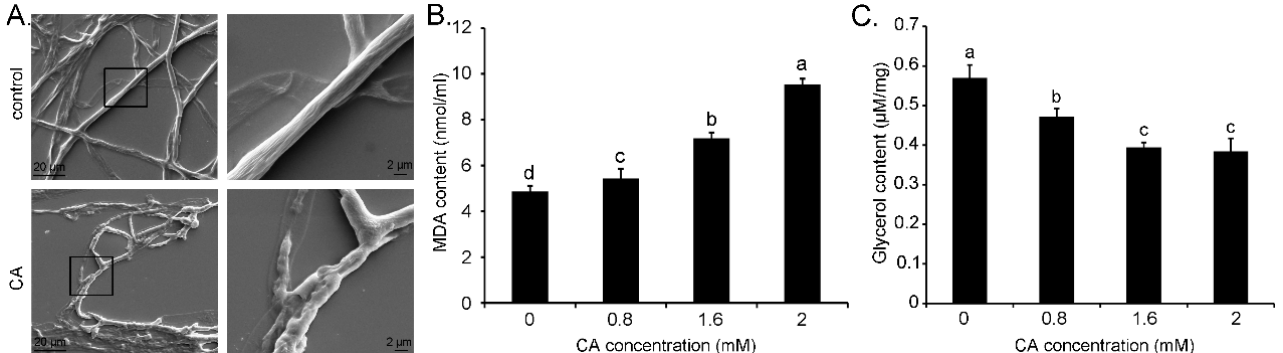
Figure 2. The defect in cell wall integrity of mycelia treated with CA/ ( A ) SEM observation of the hyphal morphology of P. capsici treated with 1 mM CA; ( B , C ) MDA content and glycerol content of the mycelia of P. capsici . Mycelia treated with CA at 0, 0.8, 1.6, and 2 mM for 24 h were harvested for the measurements. Each value is presented as the average of three replicates. Letters indicates that mean values are significantly different ( p < 0.05) between the treatment and the control.